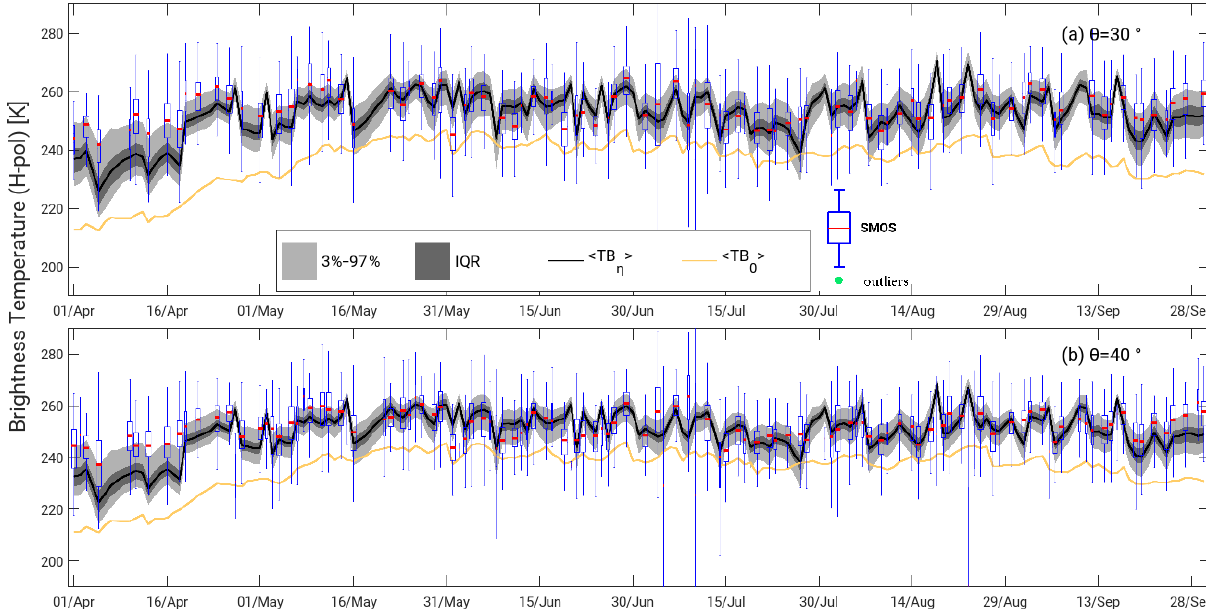
Figure 10. Area-averaged L-band brightness temperature the period from April to September 2011 for an incidence angle of 30 ◦ (a) and 40 ◦ (b) . The boxplots indicate the real SMOS observations averaged over the same domain. The black line is the median of the observations simulated with CMEM. The dark gray area corresponds to the interquartile range (IQR), while the light gray area encompasses the 3% to 97% range. The continuous orange line indicates the brightness temperature without taking into account an assumed bias in surface soil moisture content (see